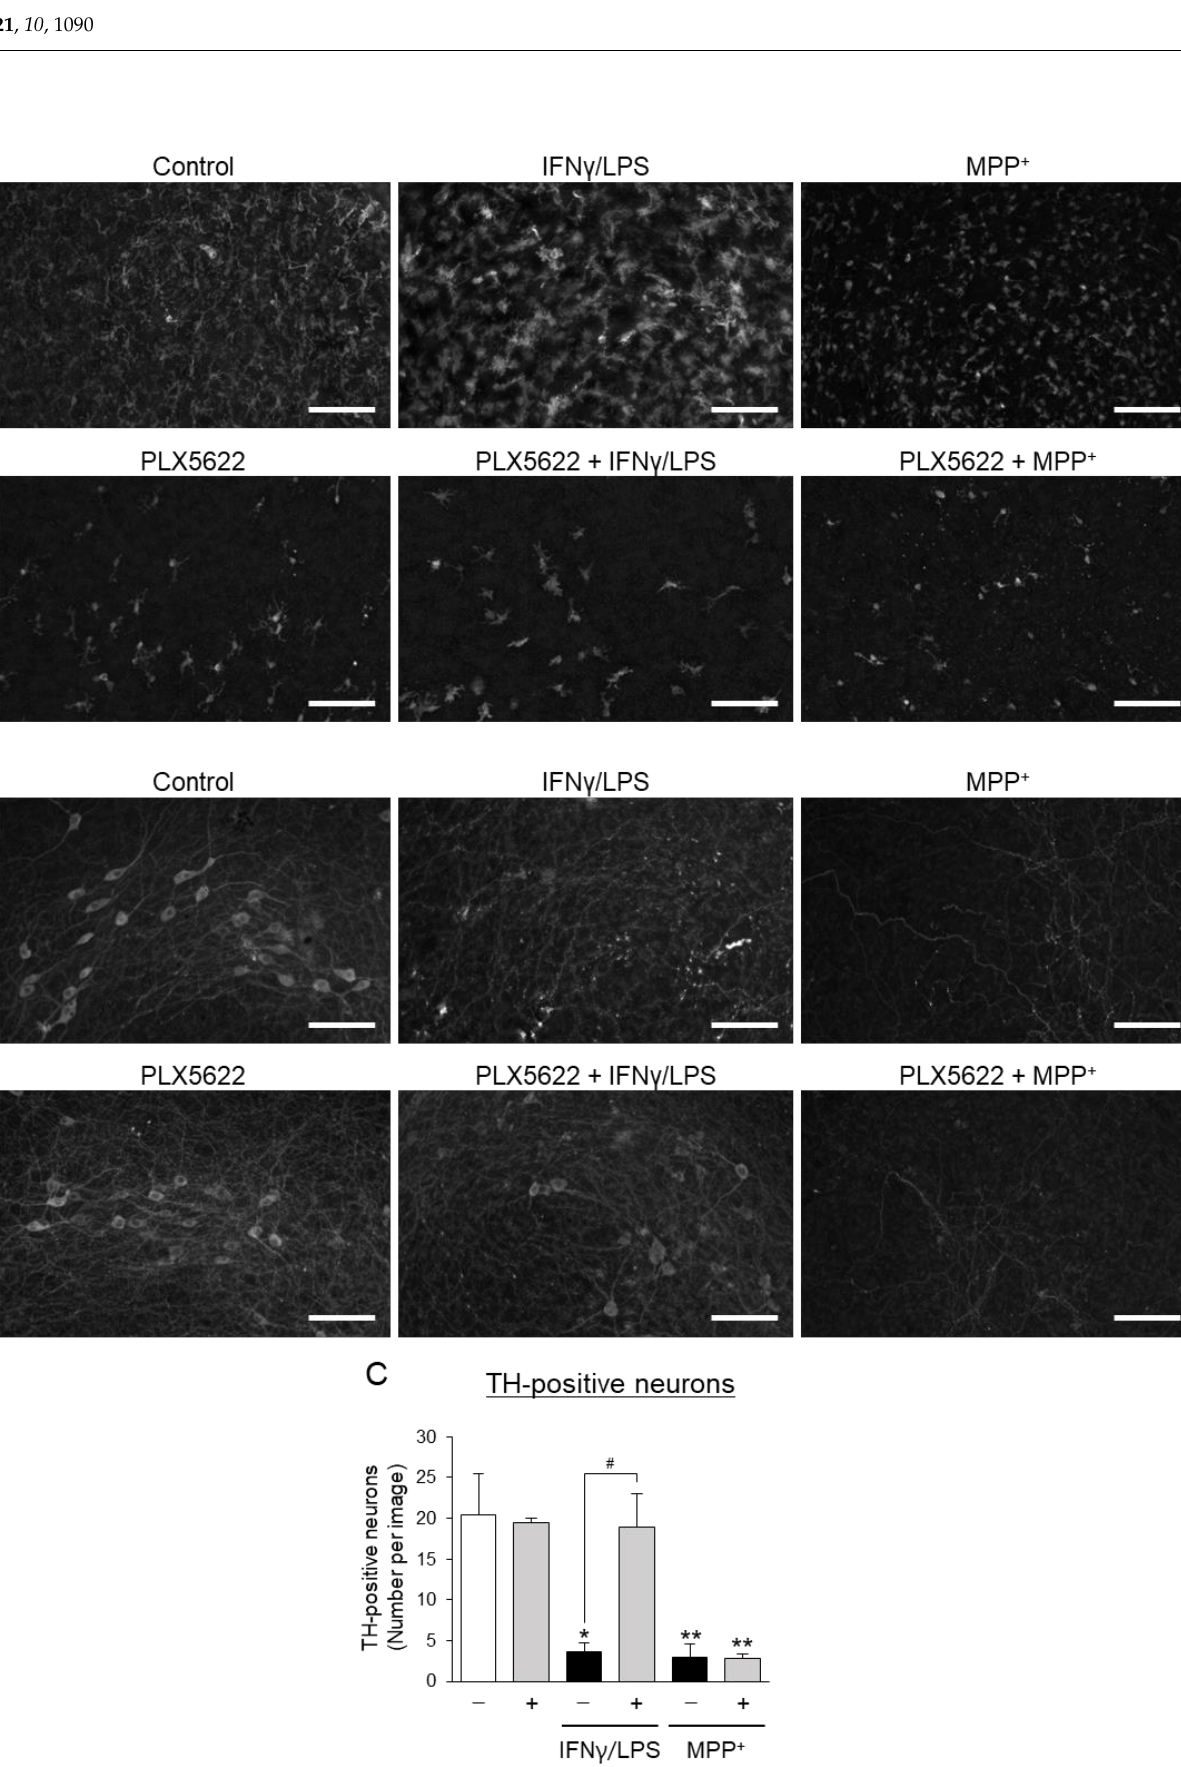
Figure 4. Effect of microglial reduction on dopaminergic neurodegeneration in midbrain slice cultures. ( A , B ) Representative images of Iba1 ( A ) and TH ( B ) immunoreactivity in midbrain slice cultures. Slice cultures were maintained in the